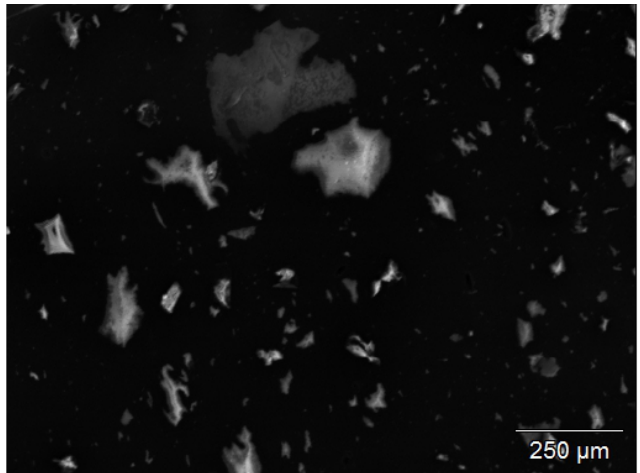
Figure 4. SEM-EDX picture of remaining particles from the devulcanizate after TGA. Pure silica is detected, 100–250 µ m, relevant for the visual granularity of the